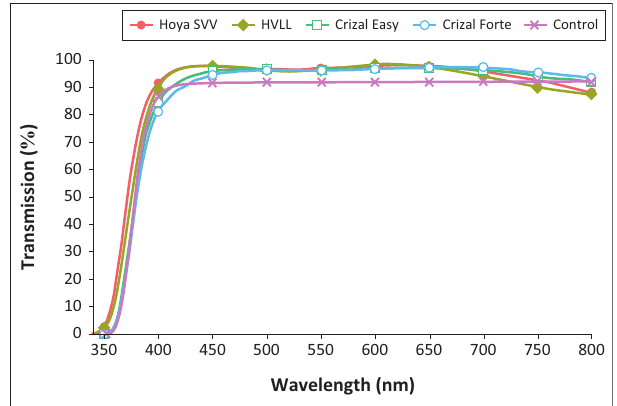
FIGURE 4: Transmission curves for four lenses with antireflection coatings. Hoya SVV (red), Hoya HVLL (green), Crizal Easy (green), Crizal Forte (blue) and the control lens (magenta).